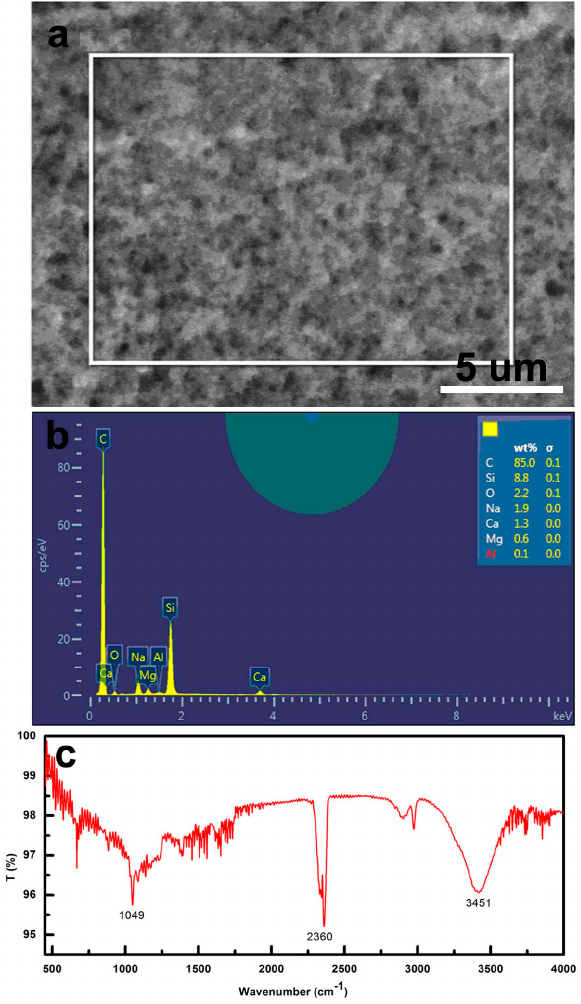
Figure 6. Chemical characterization of the CS film: ( a ) test area on CS film of EDS; ( b ) the chemical characterization (EDS); ( c ) FTIR of CS film.